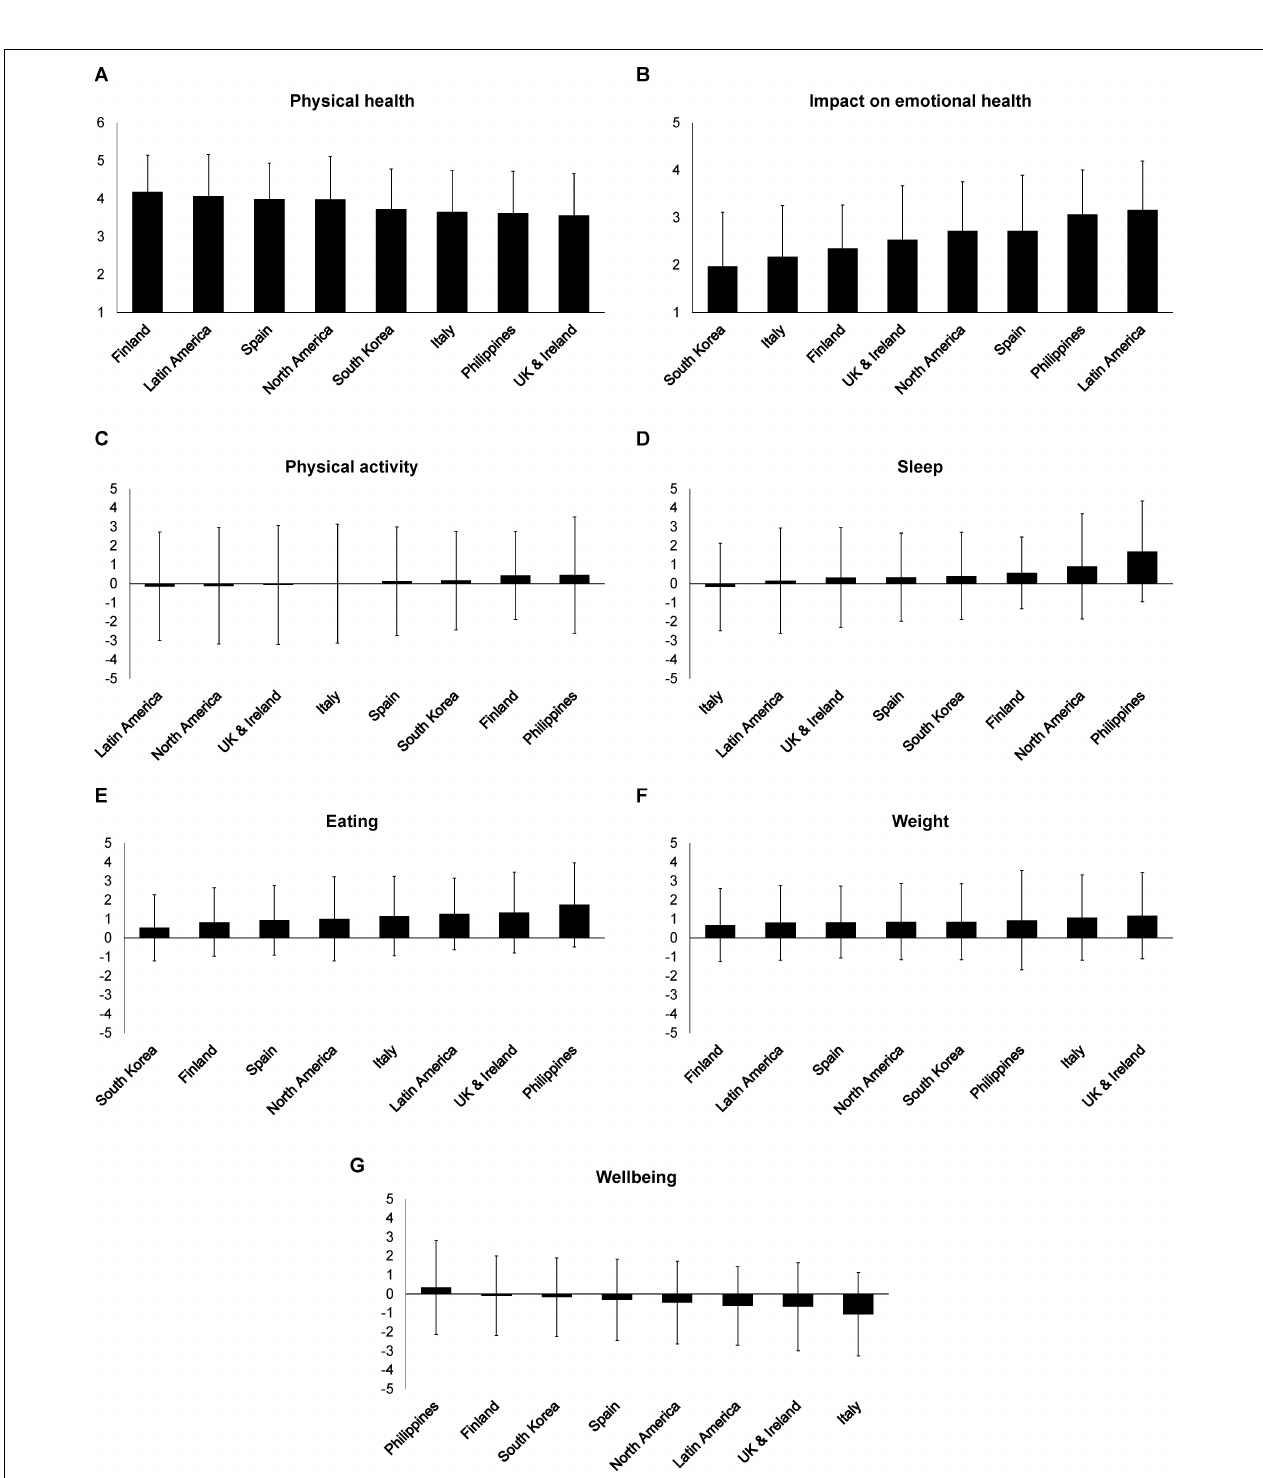
FIGURE 2 | Means and standard deviations of the reported physical (A) and emotional (B) health perceived over the last week, reported changes in physical activity (C) , sleep (D) , eating behaviors (E) , weight (F) , and wellbeing (G) during the COVID-19 pandemic across countries ( N = 1,131).